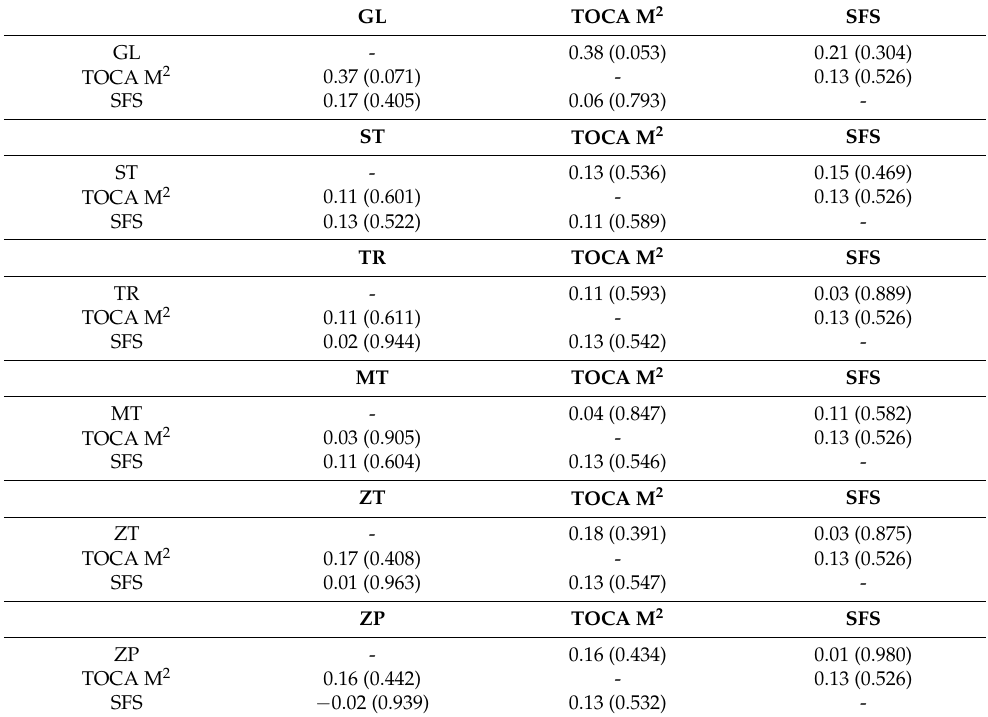
Table 7. Results of Spearman’s rank correlation analysis (top) and partial rank correlation analysis (bottom) obtained for examined traits including the TOCA of M 2 s—female cranial